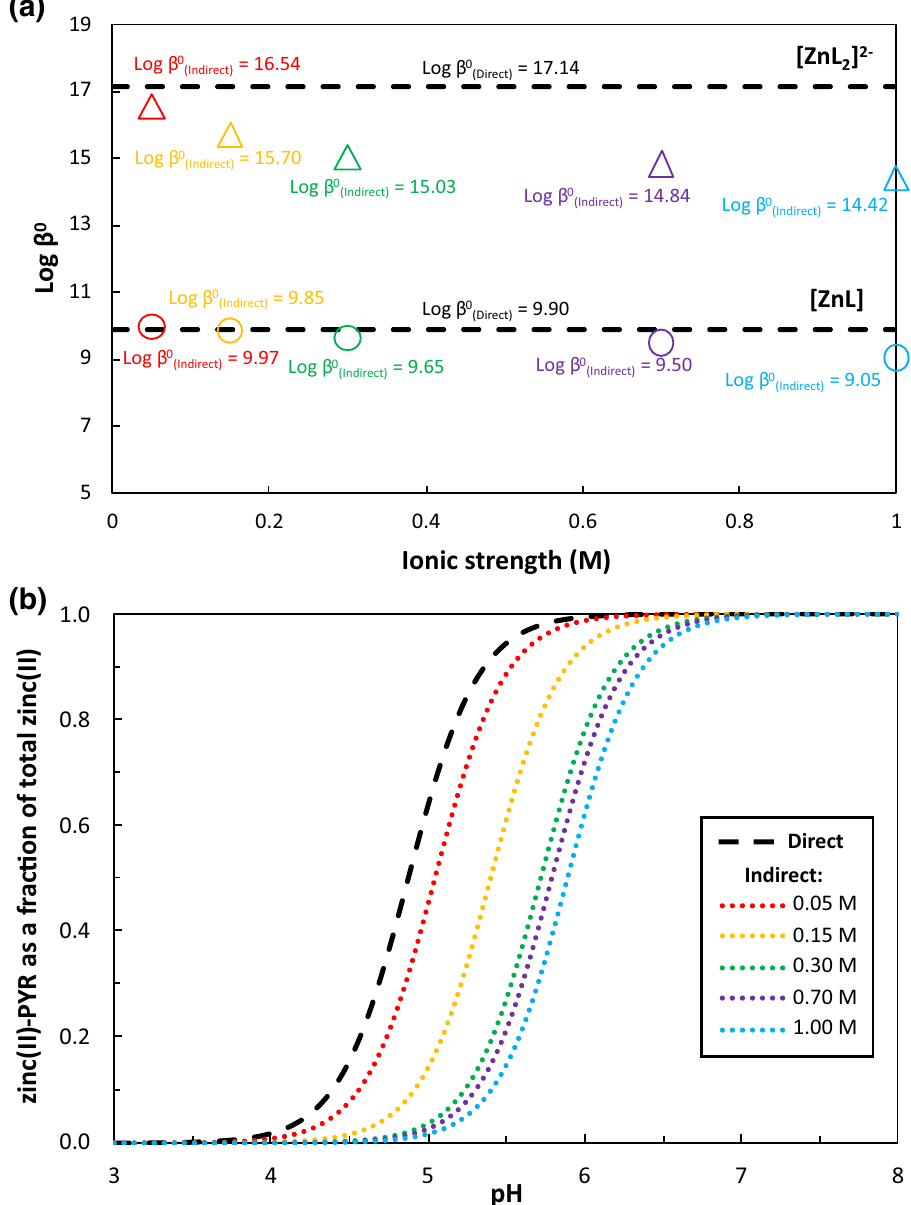
Figure 2. ( a ) Intrinsic stability constants for the formation of two zinc(II)-PYR (where PYR is pyrocatecholate) species ([ZnL], shown as circles, and [ZnL 2 ] 2- , shown as triangles) at different ionic strengths calculated indirectly using the Davies equation. The intrinsic stability constants for the same two species determined directly by fitting the modified version of the Extended Debye–Hückel equation to the full ionic strength dataset are shown as dashed lines. The error on the intrinsic stability constants is reported in Table S4. ( b ) Fraction of complexed zinc(II) in a [Zn] = 10 –6 and [PYR] = 10 –5 system modelled at infinite dilution using intrinsic stability constants determined (i) directly, by fitting the modified version of the Extended Debye–Hückel equation to the full ionic strength dataset; (ii–vi) indirectly, using the Davies equation to calculate activity coefficients and correct the zinc(II)-PYR stability constants at 0.05, 0.15, 0.30, 0.70 and 1.00 M